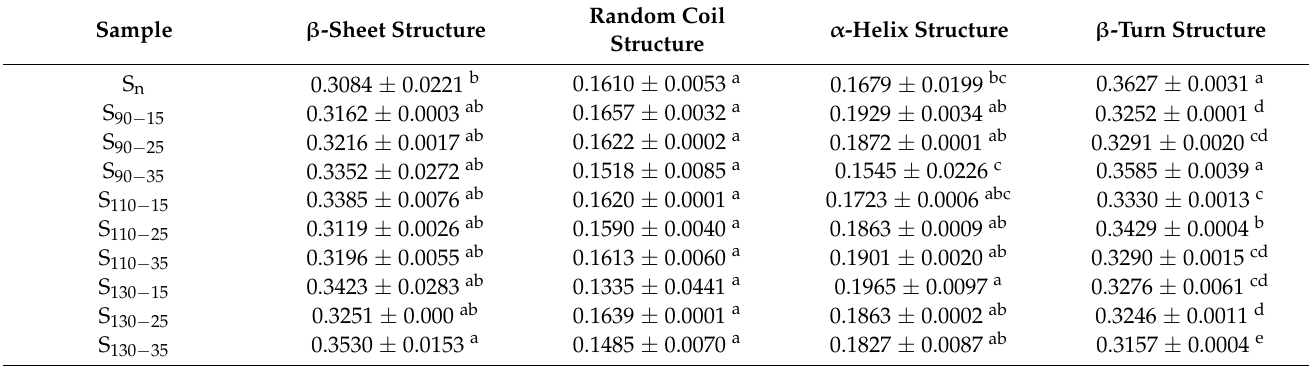
Table 5. Secondary structure of protein of native and HMT HB